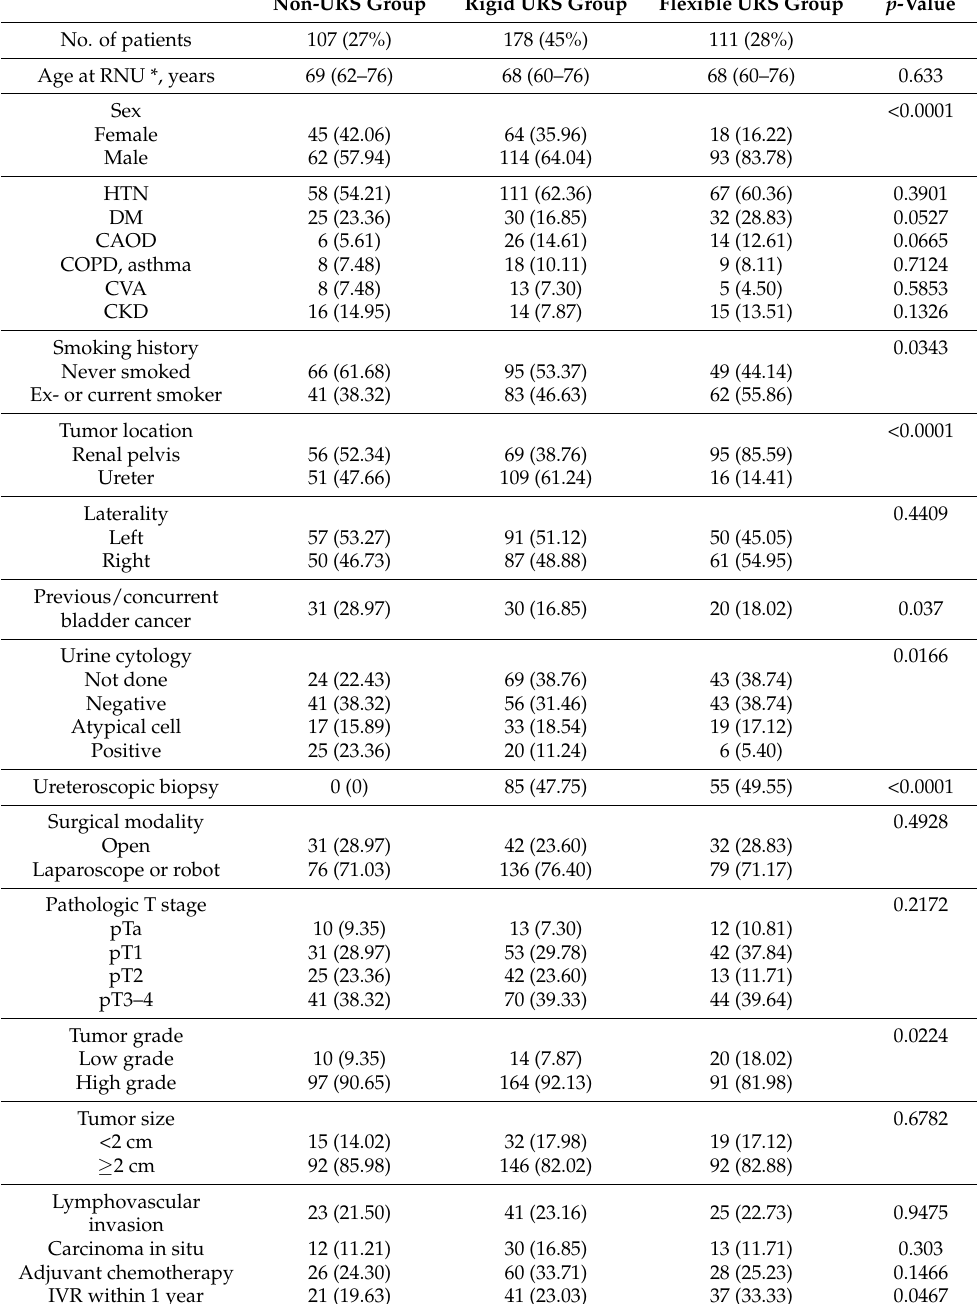
Table 2. Comparison of clinicopathological features according to the type of diagnostic